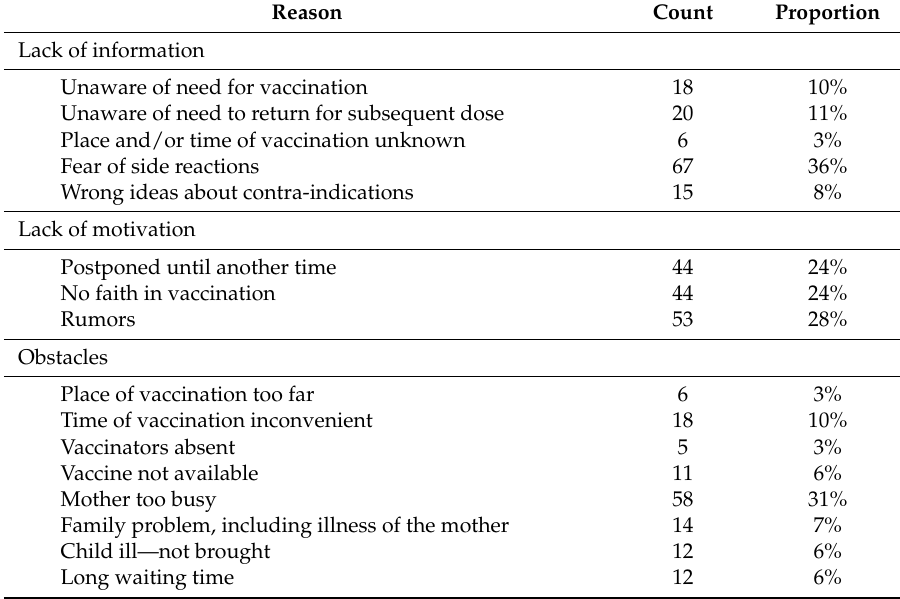
Table 4. Mothers’ reasons for not vaccinating child among those missing a child’s vaccination dose in Worabe, Southern Nations, Nationalities, and Peoples’ Region, Ethiopia,